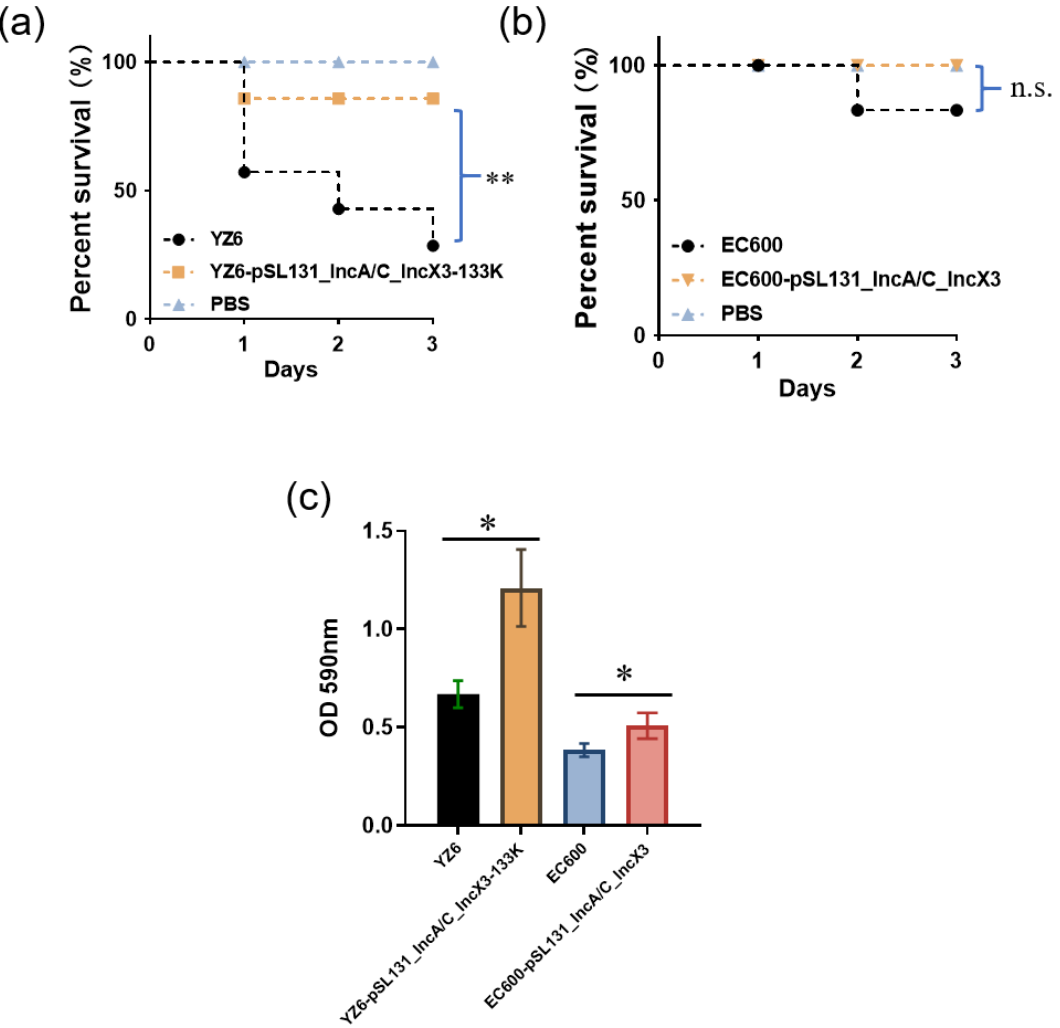
Figure 5. Results of virulence assay and biofilm formation ability of YZ6 and EC600, and their corresponding transconju- gants. ( a ) Virulence potential of YZ6 and YZ6-pSL131_IncA/C_IncX3-133K in a G. mellonella infection model. ** p < 0.01. ( b ) Virulence potential of EC600 and EC600-pSL131_IncA/C_IncX3 in a G. mellonella infection model. n.s, no difference. ( c ) Biofilm formation ability of YZ6 and YZ6-pSL131_IncA/C_IncX3-133K, EC600 and EC600-pSL131_IncA/C_IncX3. * p < 0.05.